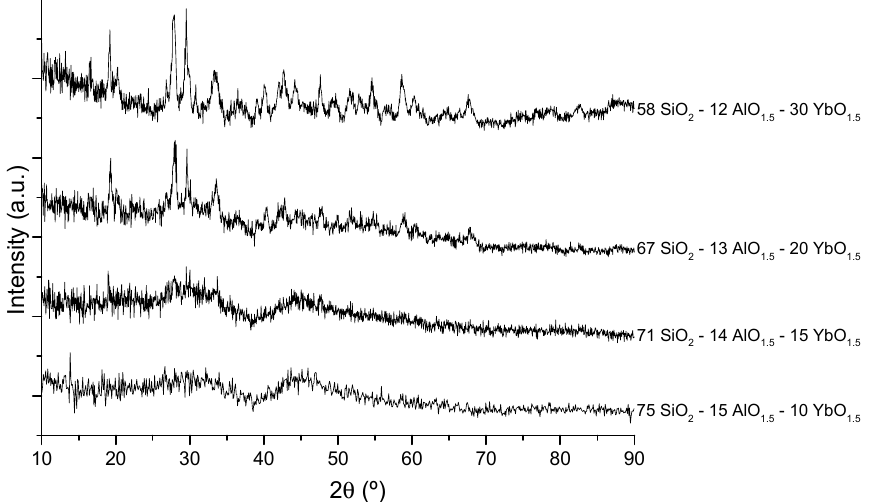
Figure 1. X-ray diffraction patterns of sol-gel derived Yb-doped aluminosilicate bulk samples, heat treated at 1050 °C.